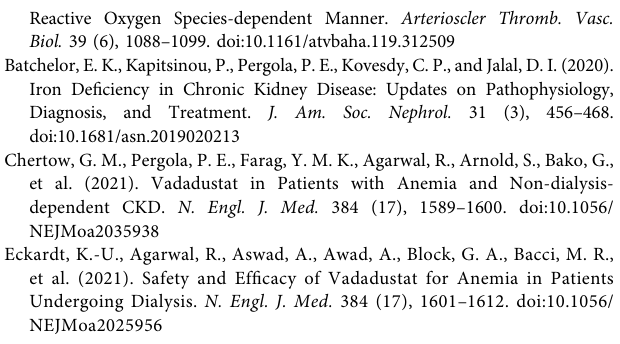
Supplementary Figure S1 | Risk of bias summary: Review authors ’ judgments about each risk of bias item for each included study. Supplementary Figure S2 | Major adverse events included all-cause mortality, cardiac events and nonfatal stroke with vadadustat versus placebo or darbepoetin alfa. Supplementary Figure S3 | Risk ratios of nausea for vadadustat versus placebo and darbepoetin alfa. Supplementary Figure S4 | Risk ratios of diarrhea for vadadustat versus placebo and darbepoetin alfa. Supplementary Figure S5 | Risk ratios of hyperkalemia for vadadustat versus placebo and darbepoetin alfa. Supplementary Figure S6 | Change in iron metabolism parameters (hepcidin, ferritin and TIBC) with vadadustat versus placebo or darbepoetin alfa. Supplementary Figure S7 | Risk ratios of the use of rescue medications with vadadustat versus placebo or darbepoetin